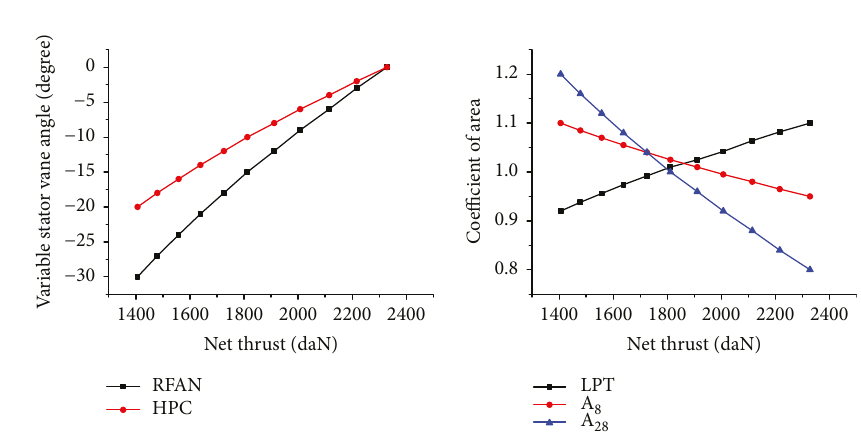
Figure 12: Installed performance calculation fl owchart.